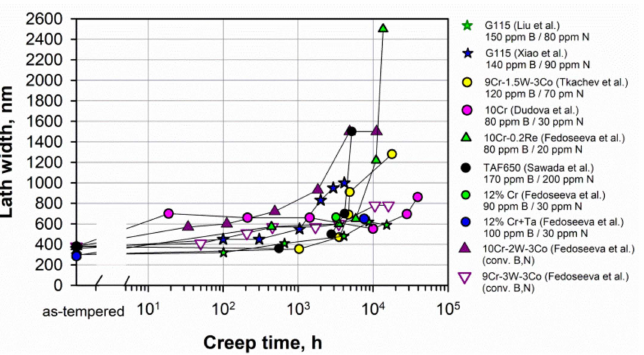
Figure 19. Evolutionofthelathwidthduringcreepinthe9–12%Crsteels. Datafrom[8,16,17,21,22,38,39,49,71].